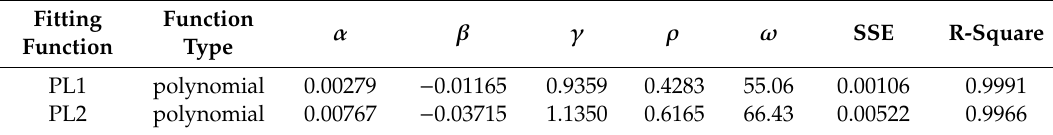
Table 7. Results and goodness of curve fitting.